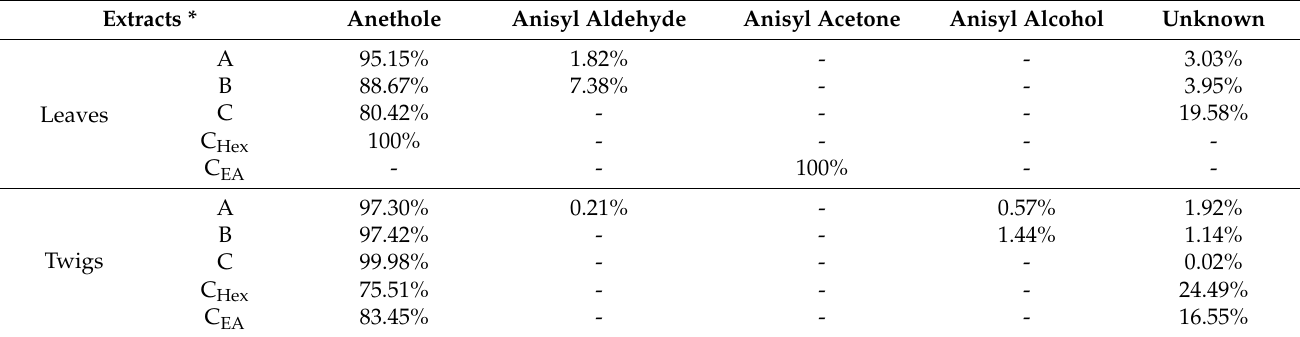
Table 5. Main active compounds of the extracts of supercritical CO 2 extraction by GC-MS